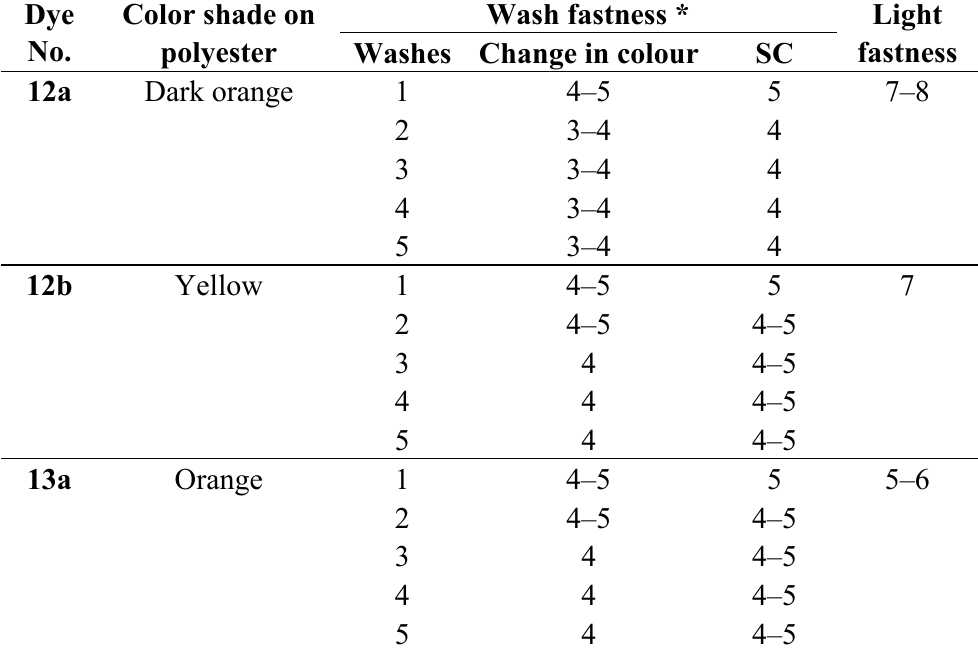
Table 2. Shade and Fastness properties of azo disperse dyes on polyester